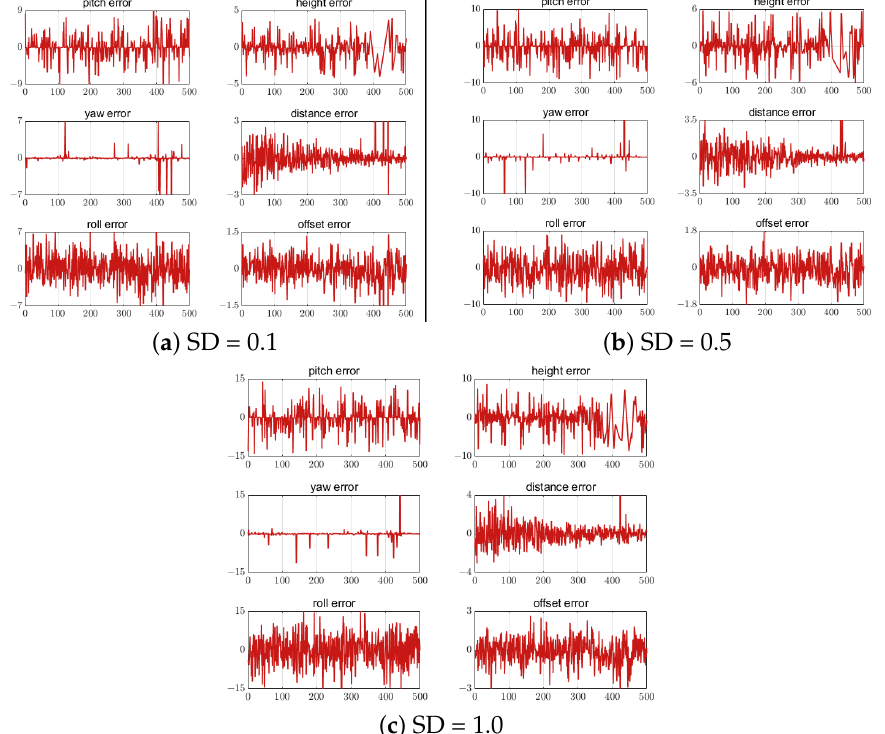
Figure 22. Error of 5 feature points with different SD. The unit of the attitude error is degree. The unit of the position error is meter. The horizontal axis in all figures is the number of measurement points.